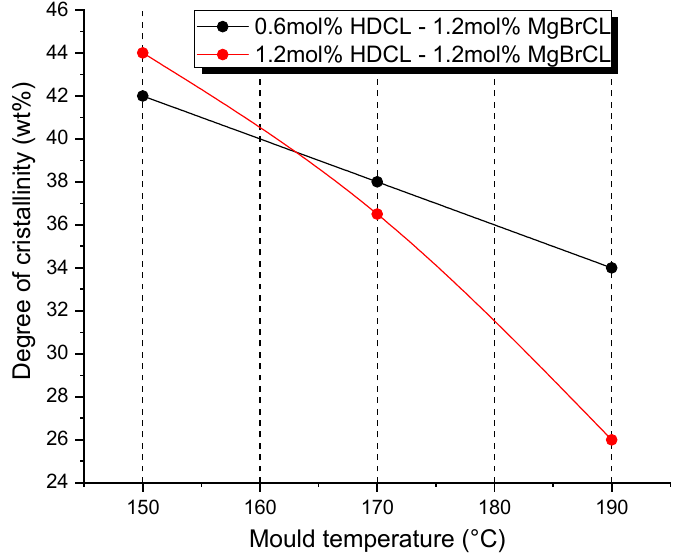
Figure 6. Degree of crystallinity at various mold temperatures for two different activator concentra- tions. Authors’ own figure based on the data from Reference [83].